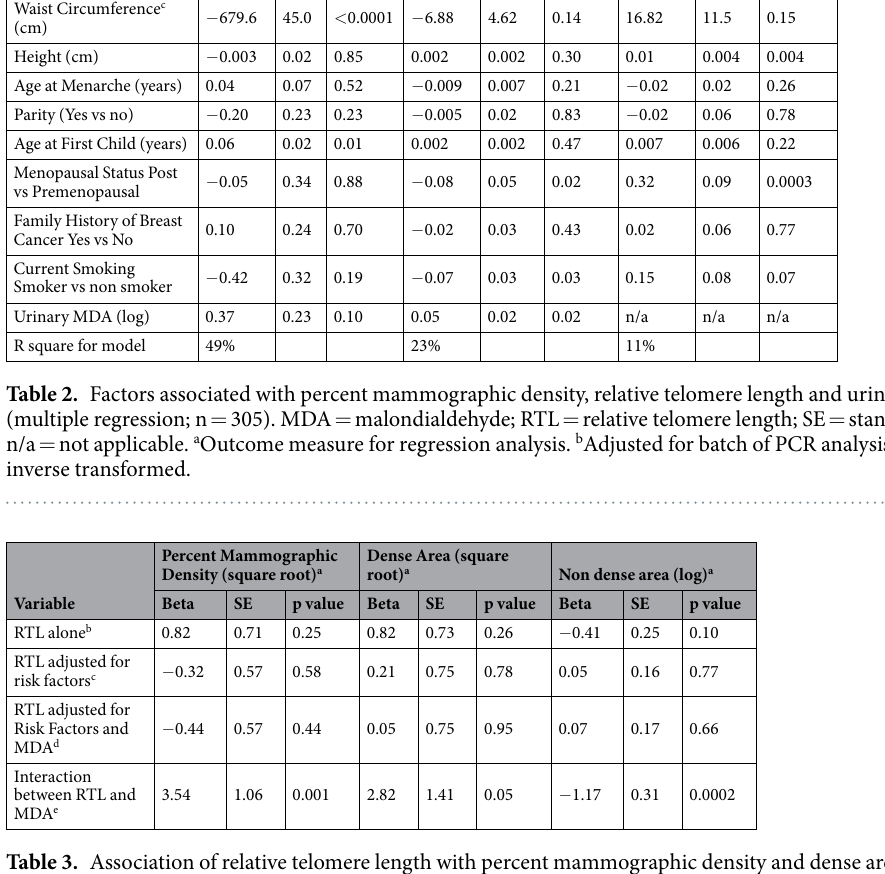
Table 3. Association of relative telomere length with percent mammographic density and dense area before and after adjustment for risk factors and urinary MDA (n = 305). RTL = relative telomere length; MDA = malondialdehyde; SE = standard error. a Outcome measure for regression analysis. b Adjusted for PCR batch only. c Adjusted for PCR batch and risk factors (from Table 2), except for MDA. d Adjusted for PCR